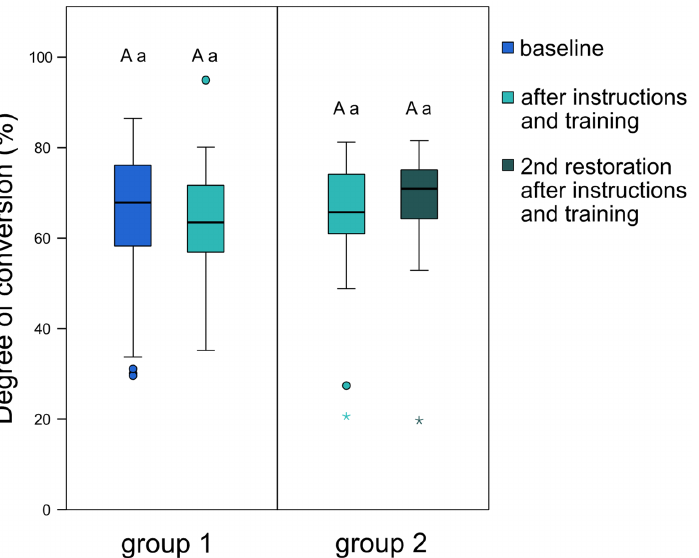
Figure 3. Degree of conversion (%) of the composite restorations of group 1 and group 2, measured at the bottom of the 4-mm-thick composite restorations. For group 1, degree of conversion was as- sessed of composite restorations placed before and after individual instructions and training; for group 2, both degree of conversion assessments were performed on composite restorations placed after individual instructions and training. The boxplots show the medians (bold black lines), and the boxes represent the 25 % and 75 % data quartiles, whereas the whiskers represent 1.5 × inter- quartile range (IQR), or minima and maxima of the distribution if below 1.5 × IQR; outliers are shown by circles, and extreme outliers are presented by asterisks. Groups marked with different uppercase letters (intra-group comparisons) or different lowercase letters (inter-group comparisons) are significantly different from each other ( p <